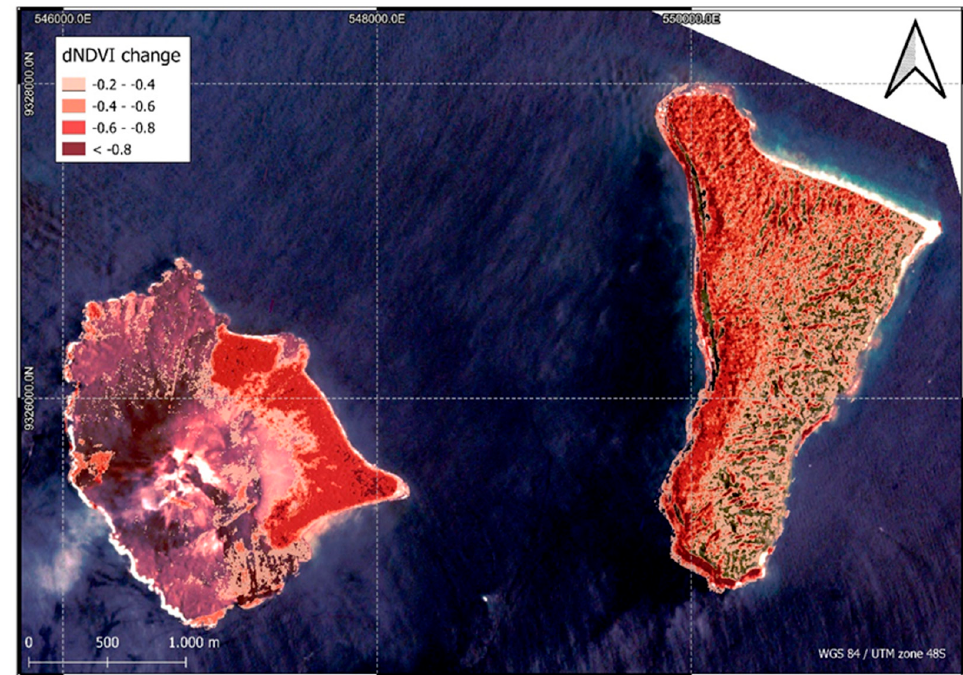
Figure 4. Vegetation changes after the 22 December 2018 eruption at Krakatau (II) based on the dNDVI . Former vegetation areas in the E of Anak Krakatau were destroyed by the eruption. On Kecil island E of Anak Krakatau, there were thick ash and tephra deposits, as well as vegetation loss on the W coasts due to the tsunami wave.